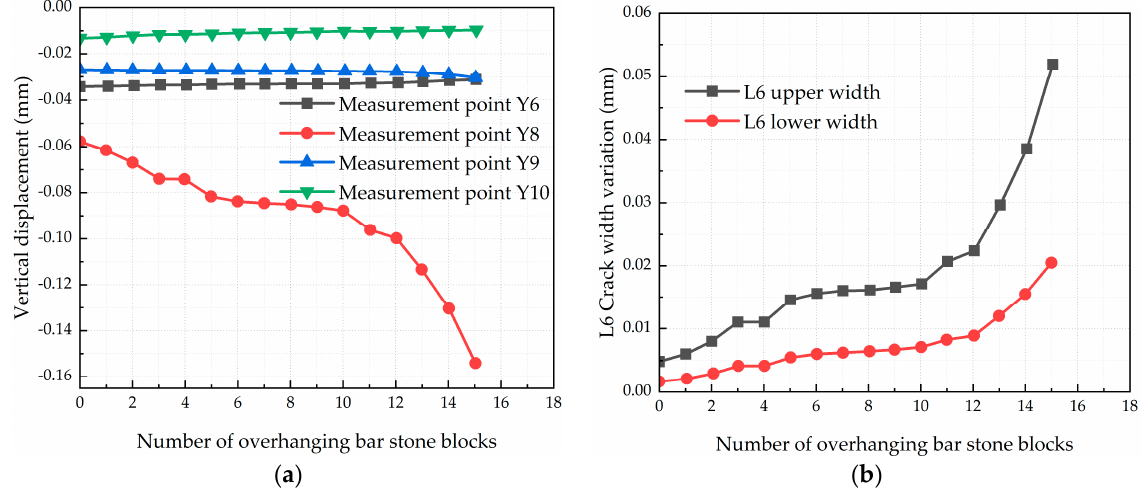
Figure 11. ( a ) The variation curve of vertical displacement of each measurement point with the number of overhanging slate blocks; ( b ) the variation curve of the increase of L6 crack width with the number of overhanging slate blocks.